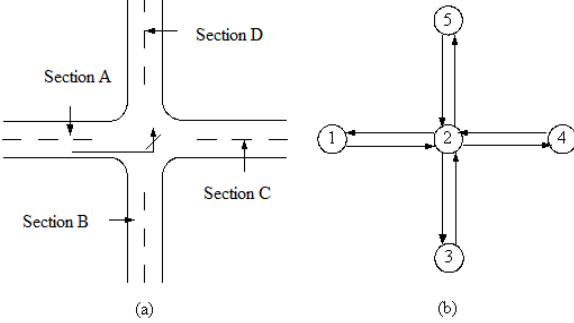
Fig.1 Schematic diagram for road intersection representation by using a conventional weighted directed graph